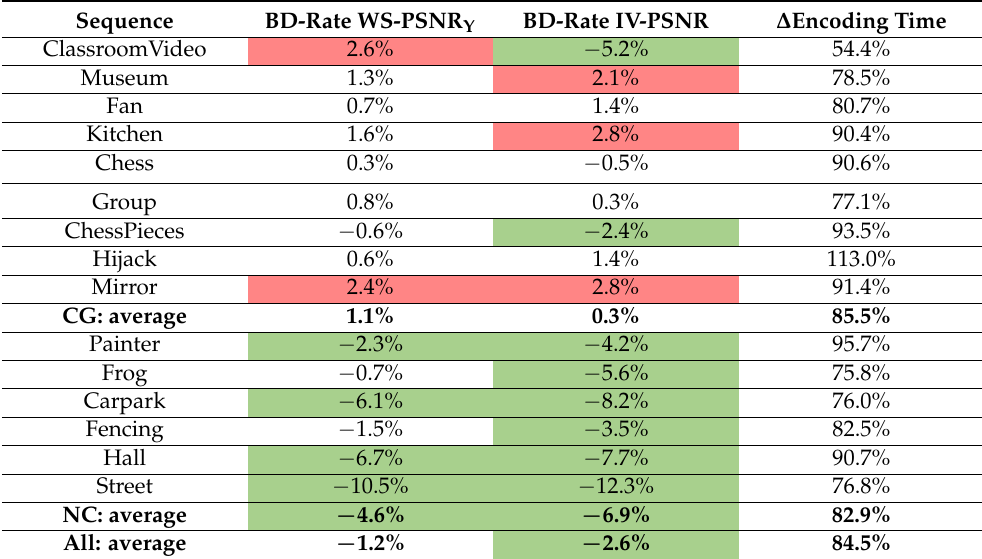
Table 4. Basic SCC vs. SCC with quarter-pel IBC accuracy and tile-based IBC analysis for first texture atlas; BD-rate change higher than 2% was highlighted in red (for efficiency loss) or green (for efficiency